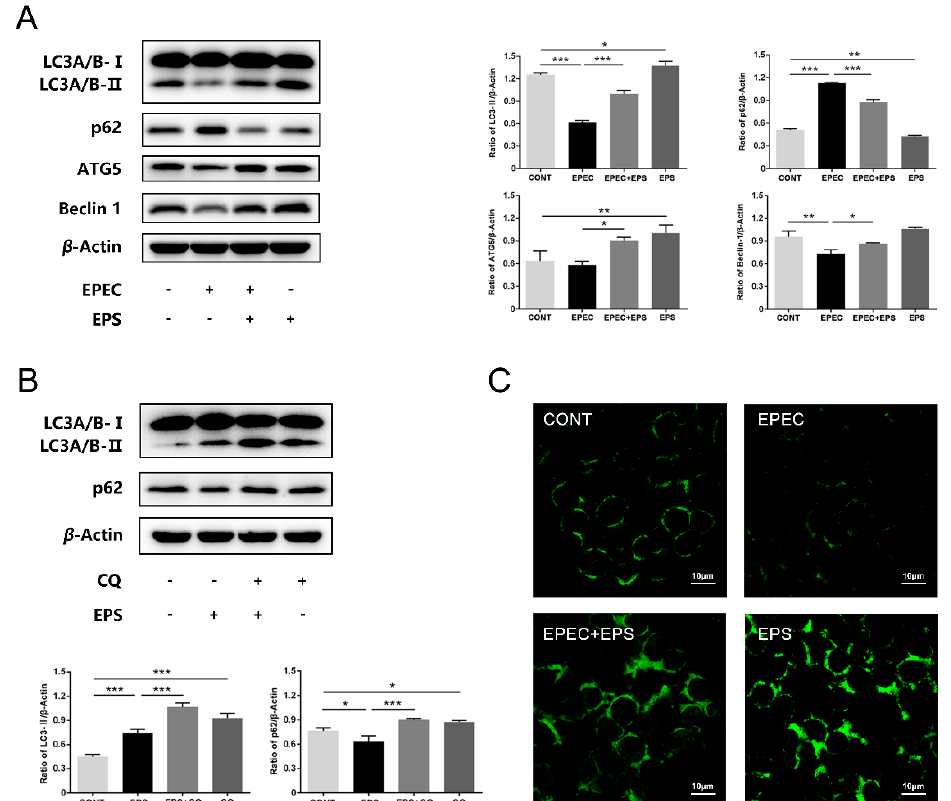
Figure 3. EPS restored the autophagy flux inhibited by EPEC in IPEC-J2 cells. ( A ) The protein expressions of LC3, p62, ATG5, and Beclin 1 in IPEC-J2 cells and right panels were the quantitation analysis by Image J software. ( B ) CQ was added 1 h before co-incubated with EPS for 2 h to inhibit autophagic degradation, western blot analysis for the protein expressions of LC3 and p62 in IPEC-J2 cells was showed, and the panel below was the quantitation analysis by Image J software. ( C ) Autophagosome formation was assessed by MDC staining. Representative autophagosome formation of autophagy was presented. Scale bars, 10 µ m. The data was presented as mean ± SEM ( n = 3), * p < 0.05, ** p < 0.01, *** p <